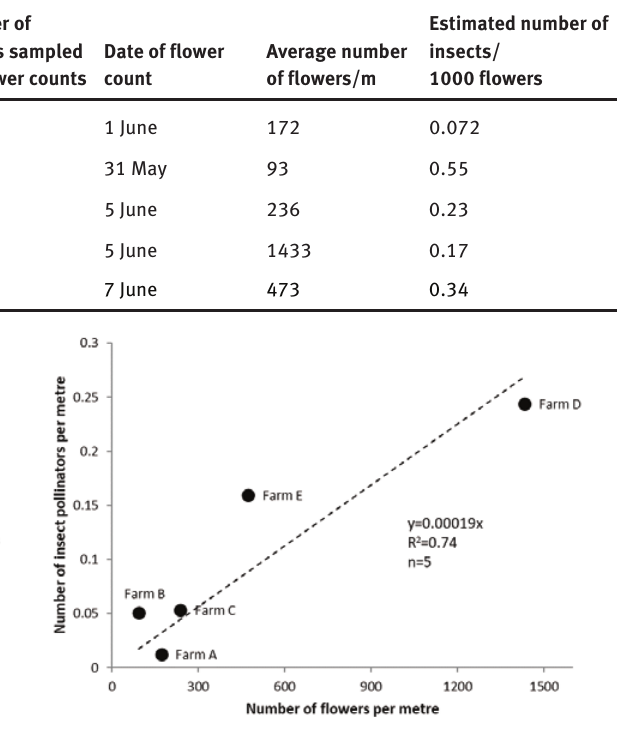
Figure 1: Composition of insect pollinators at each farm during each survey. Numbers above columns are the total number of insects observed visiting flowers at each site during each sampling period.